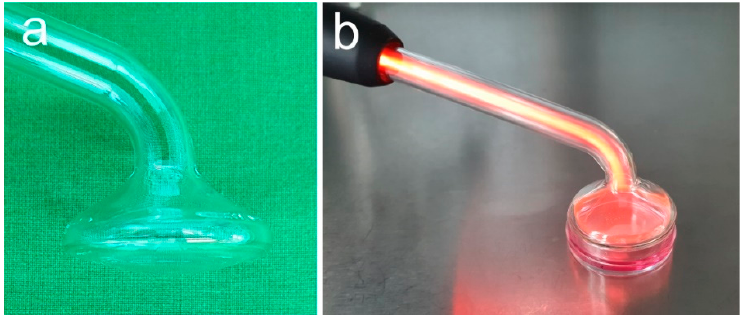
Figure 3. In vitro NIPP treatment. ( a ) Instrument probe PS30; ( b ) treatment of medium covered cells.